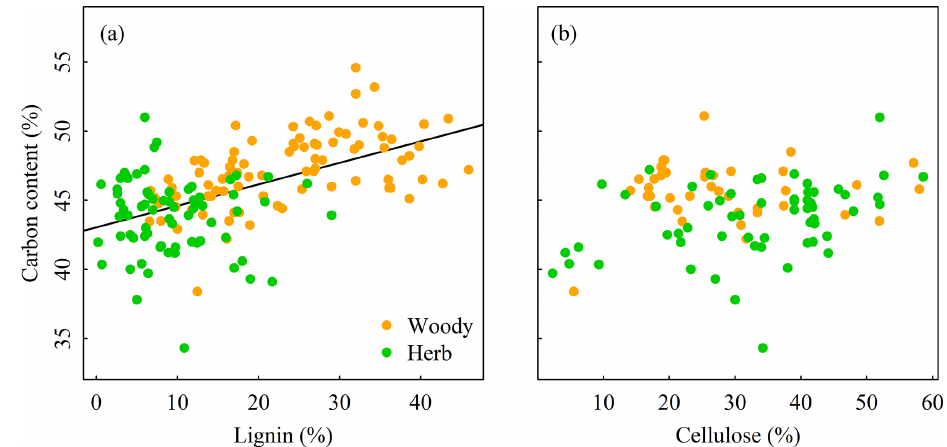
Figure 6. Relationships between plant carbon content and lignin and cellulose in woody plants and herbaceous plants. Plant carbon content increases significantly with increasing lignin in plants ( r 2 = 0.29, p <0.001), whereas it is not correlated with the cellulose in